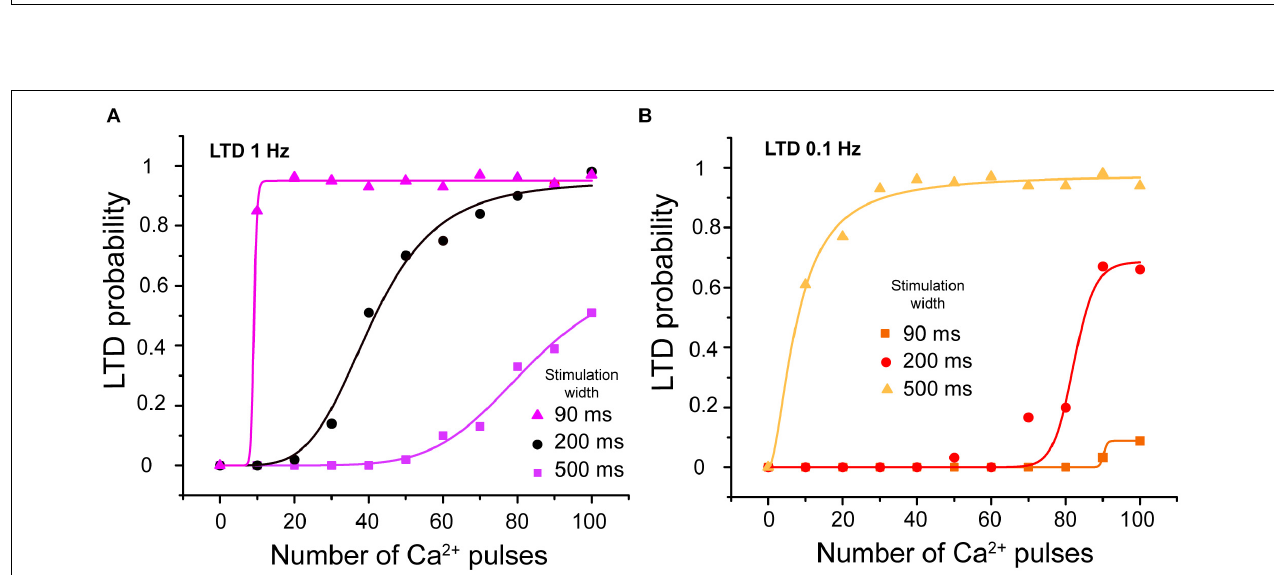
FIGURE 7 | LTD probability as a function of calcium stimulus width. (A) Relationship between number of Ca 2 + pulses and LTD for different widths of calcium influx per pulse, with 90, 200, and 500 ms at 1 Hz and (B) 0.1 Hz. Every symbol (square, circle or triangle) represents the probability to get LTD state at specific number of Ca 2 + pulses and frequency over 100 trials. LTD probability increases when the width of calcium pulses increases and decreases when this decreases at both frequencies.